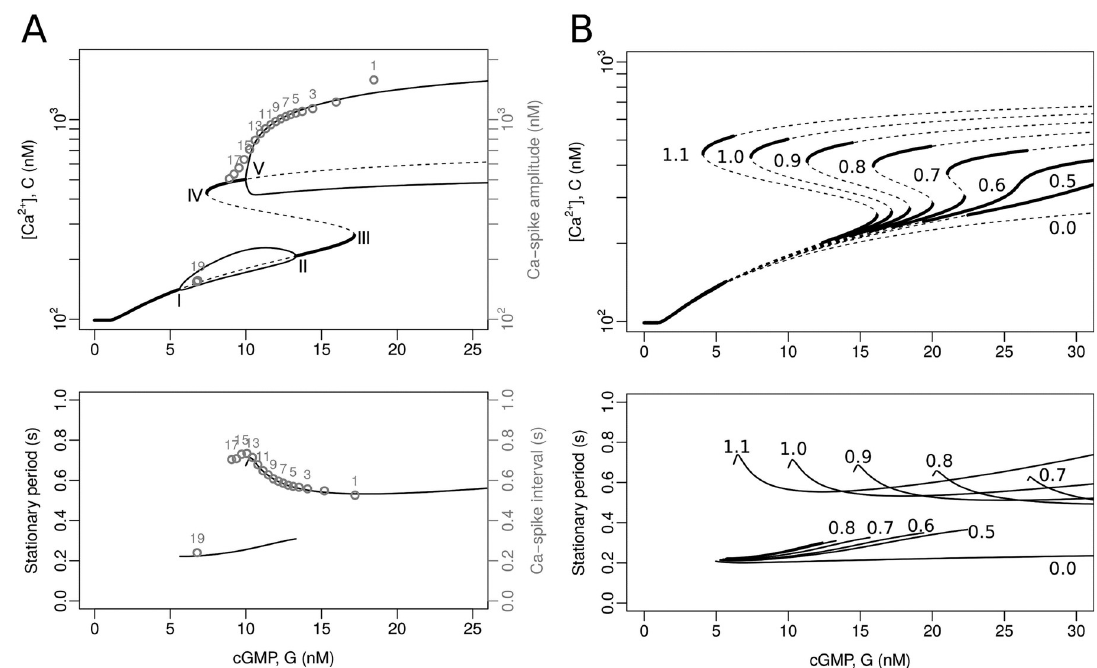
Fig 5. Bifurcation analysis of the model featuring the Ca V +BK module. In this analysis, cGMP concentration is a constant input, i.e. G is the bifurcation parameter and the upstream variables are ignored, thus reducing the state space to f f o Bifurcation diagrams calculated with XPPAUT [24] using the reference parameters (Table 2). Top: the graphs show the C variable ([Ca 2+ ] i ) as a function of the input parameter G (cGMP concentration). The thick continuous lines are stable equilibria, the dashed ones indicate unstable equilibria, the thin continuous lines are the maxima and minima of stable limit cycles. The bifurcation points are marked with Roman numerals (I to V). The numbered grey circles indicate the peak value for consecutive spikes obtained by numerically solving the complete model (see Fig 4). Bottom: the solid lines represent the period of stable limit cycles as a function of the constant input G . The numbered gray circles correspond to the interspike interval in the numerical solutions, as in the top graph. B) Bifurcation diagrams parameterised by maximal BK conductance density ( g bk ). Top and bottom: the lines are as in the graphs in (A); for clarity, the minima and maxima of the limit cycles are omitted. The numbers in the range of 0.0 to 1.1 are the fold change factors multiplying the reference value of g bk (e.g. the curves labelled 1.0 coincide with those of (A), whereas the curves marked 0.0 correspond to a cell without BK